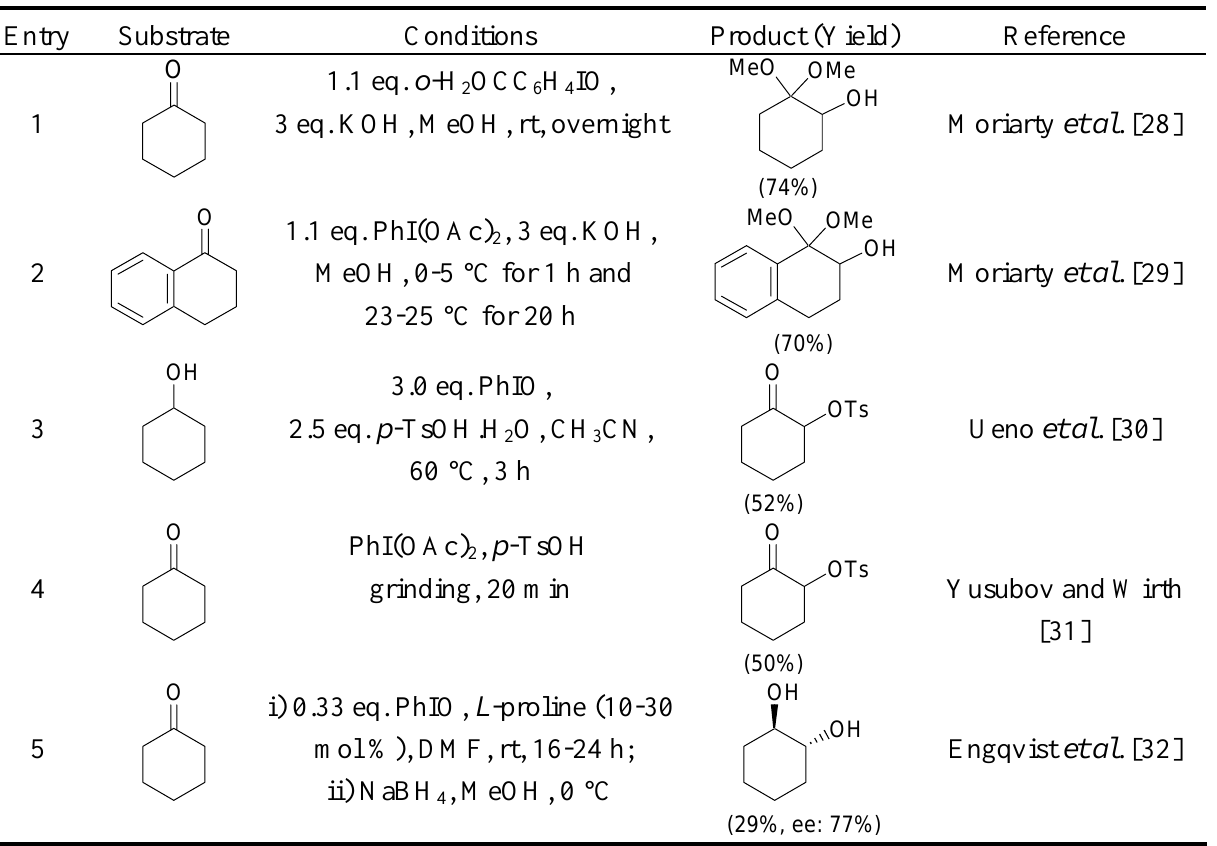
Table 2 . Representative examples of the α -oxidation of cyclic